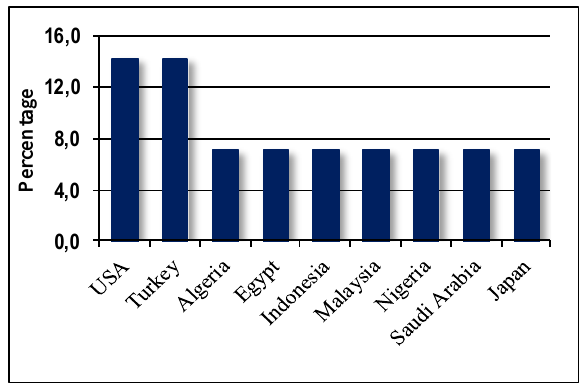
Figure 6. Countries making major contribution in implementation and research related to Gravity Field: geoid,